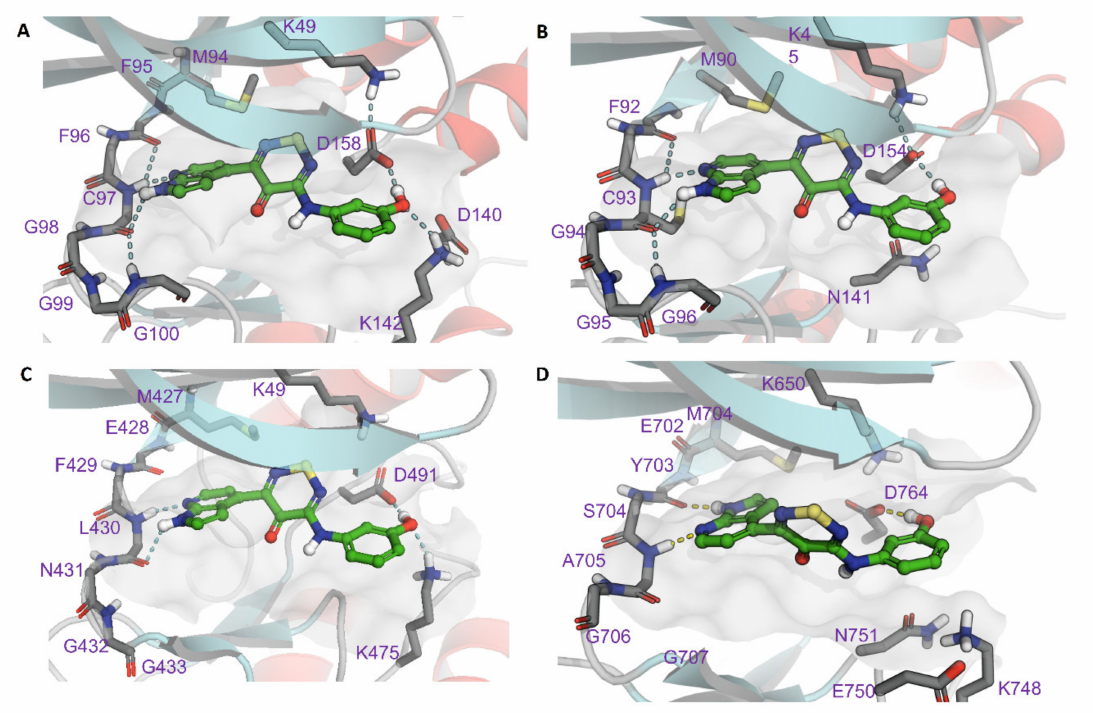
Figure 6. Molecular modeling of 16 on MIBS kinome profiling hits: ( A ) MAP4K5; ( B ) MAP4K3; ( C ) PRKCD; and ( D )